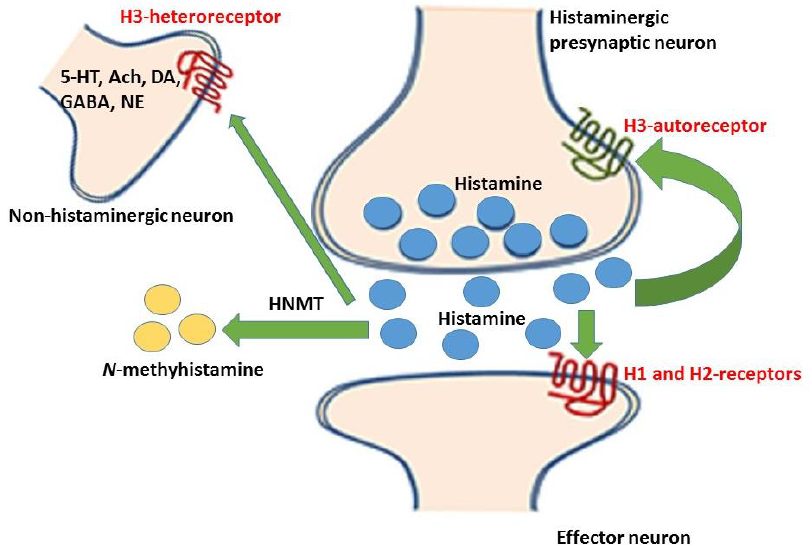
Figure 1. Released histamine (represented by the blue dots) from the histaminergic neurons bind to histamine-1 and -2 receptors on the effector neurons, while some are metabolized to the N -methylhistamine by the histamine N -methyltransferase (HNMT) enzyme. Some of the released histamine binds to the histamine-3 autoreceptors (on the histaminergic neurons) and the histamine-3 heteroreceptors (on the non-histaminergic neurons) thereby inhibiting the reuptake of released neurotransmitters. The central effect of this inhibition includes the enhancement of wakefulness, cognition, learning, and memory [13].